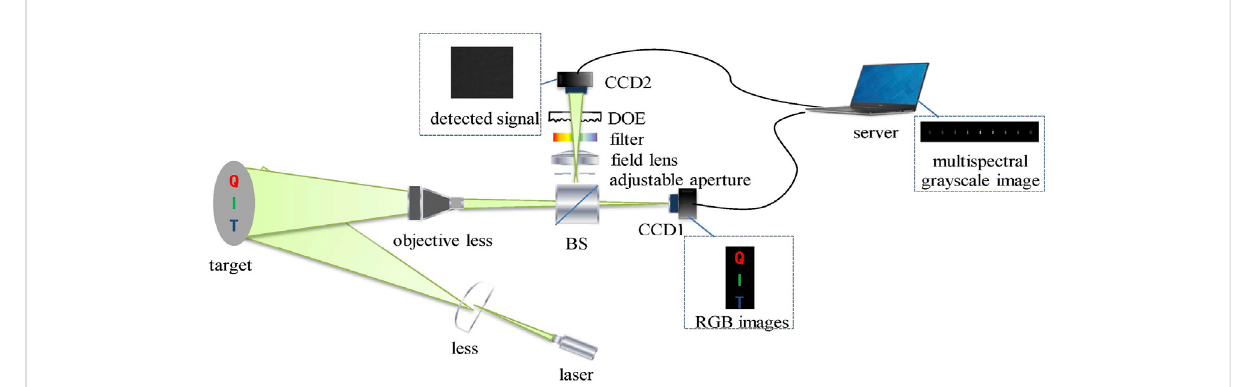
FIGURE 1 Optical path diagram of GISC spectral imaging system based on active laser illumination.